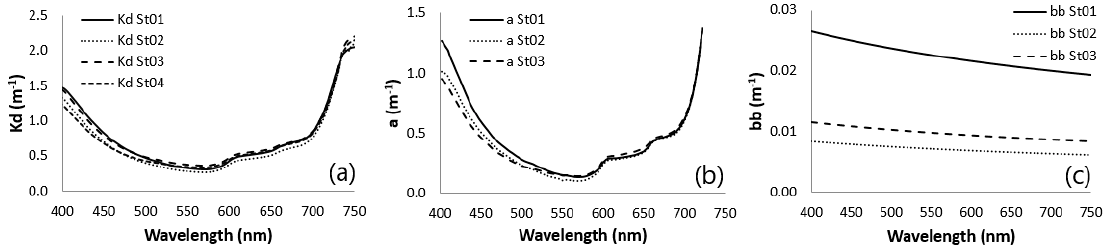
Figure 2. Overview of water optical properties at the field stations: ( a ) diffuse attenuation coefficient, K d ; ( b ) total absorption coefficient, a ; ( c ) total backscattering coefficient, b b .